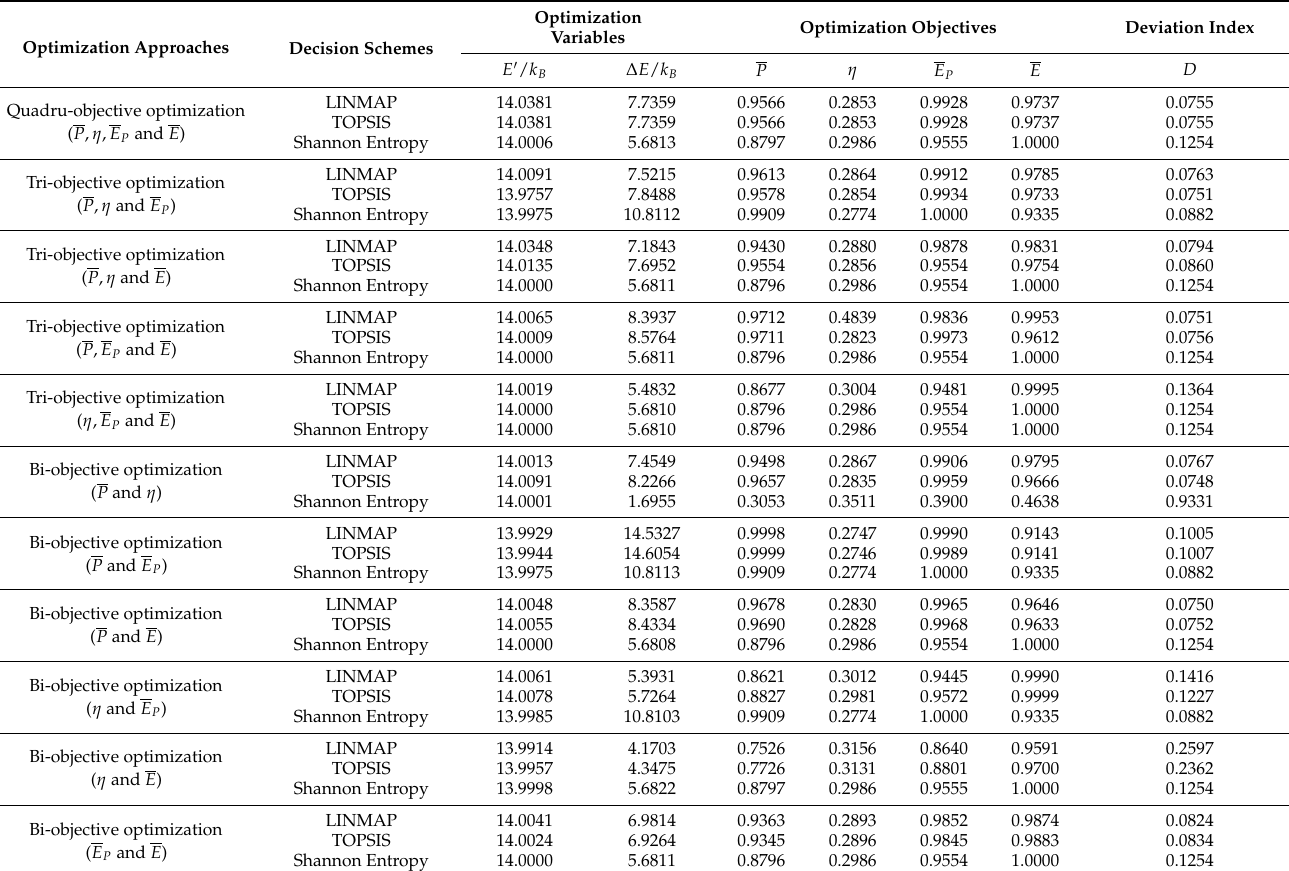
Table A1. Results of quadru-, tri-, bi- and single-objective